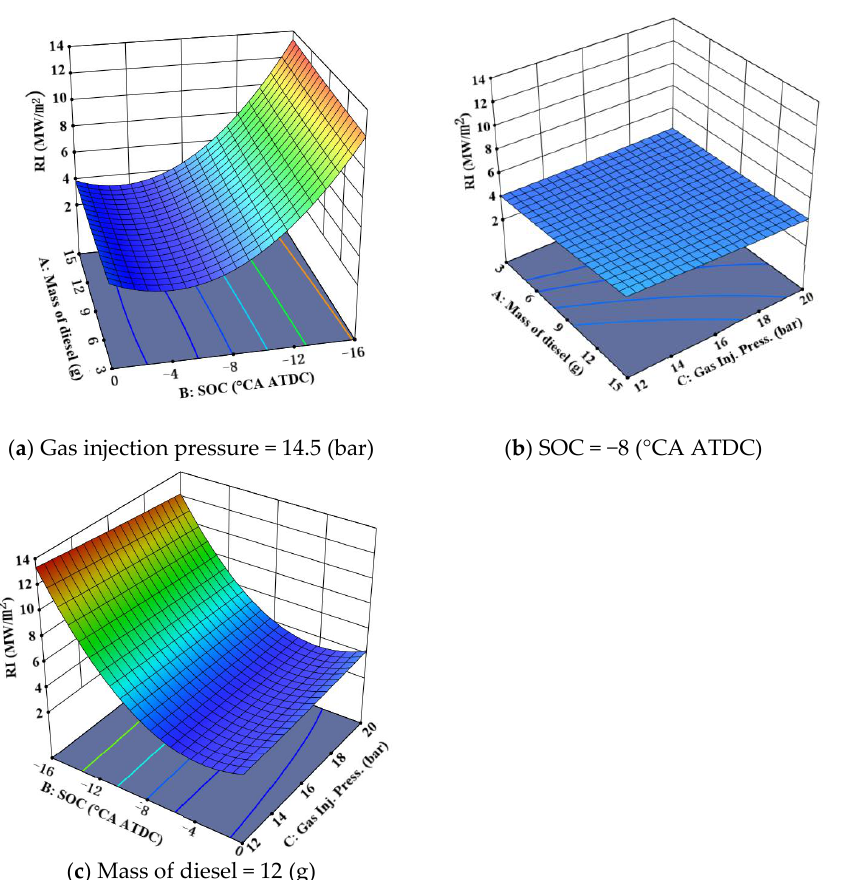
Figure 10. Response surface plot of the RI.